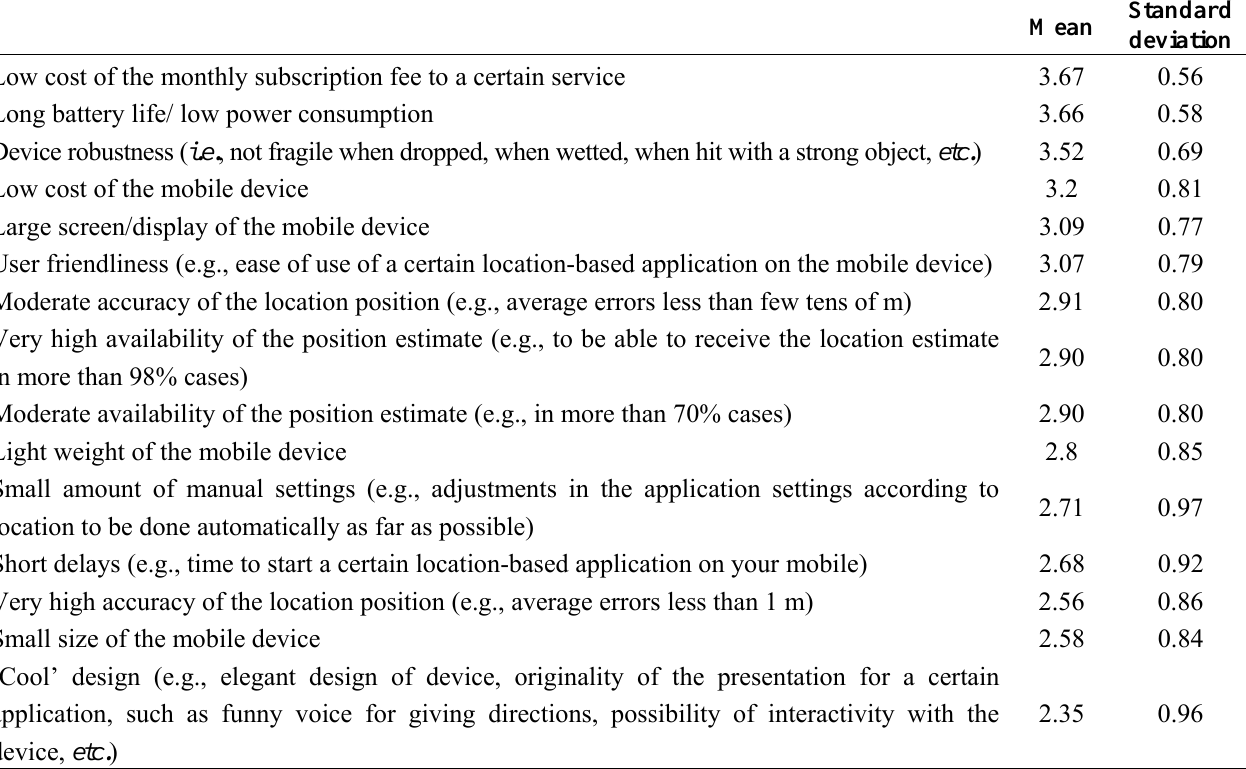
Table 1. Importance levels, assigned by users, to several mobile device features in the context of LBS, on a scale from 1 (not important) to 4 (very